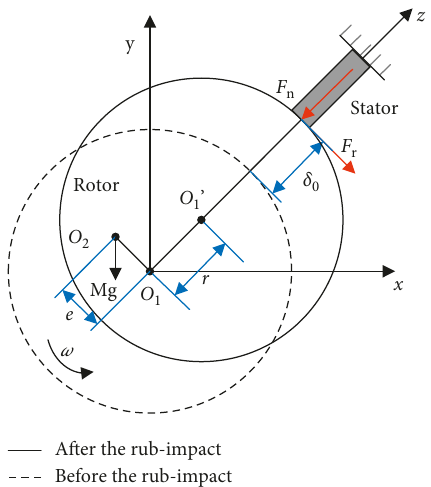
Figure 2: Mechanics model of fixed-point rub-impact.